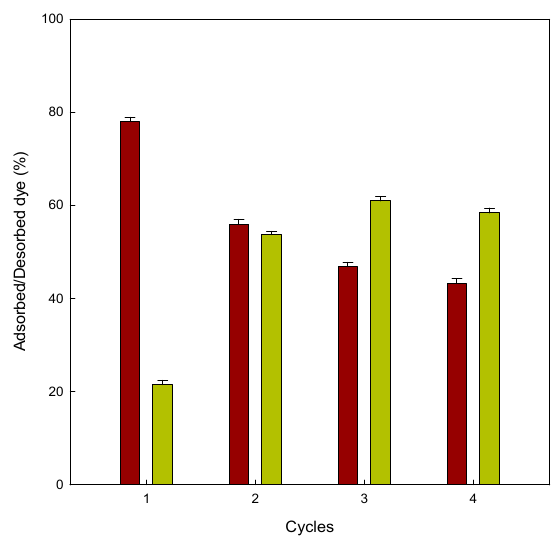
Figure 8. Adsorbed/desorbed dye (%) onto eggshell for four consecutive adsorption ( )/desorption ( Figure 8. Adsorbed / desorbed dye (%) onto eggshell for four consecutive adsorption ( (cid:4) ) / desorption ) cycles. ( (cid:4) ) cycles.